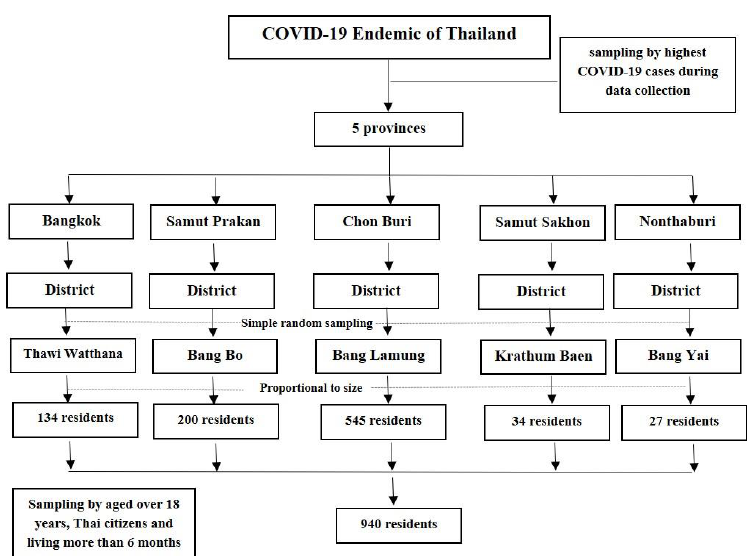
Figure 1. Study area.